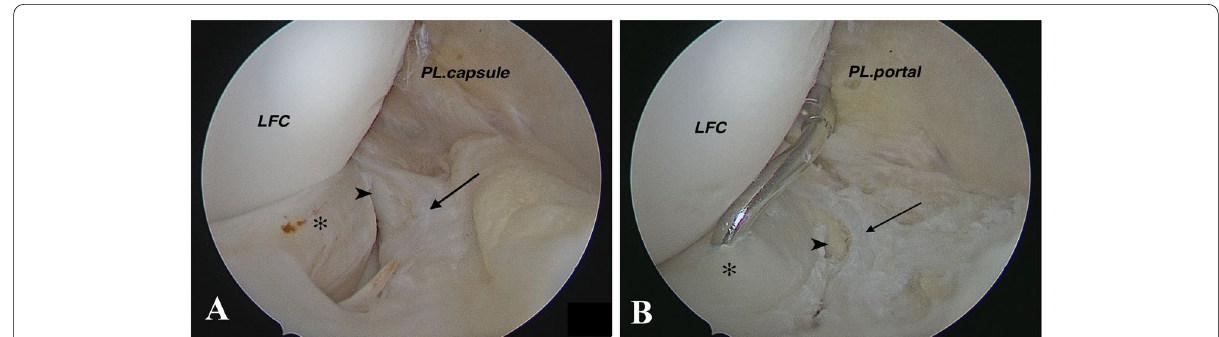
Fig. 2 Right knee arthroscopy: A Posteromedial transseptal view with a 30-degree lens that shows popliteomeniscal fascicle tear ( B ) repair by using suture hook technique from posterolateral portal. Asterisk: Lateral meniscus; Arrow: Posterosuperior popliteomeniscal tear; Arrow head: Popliteus